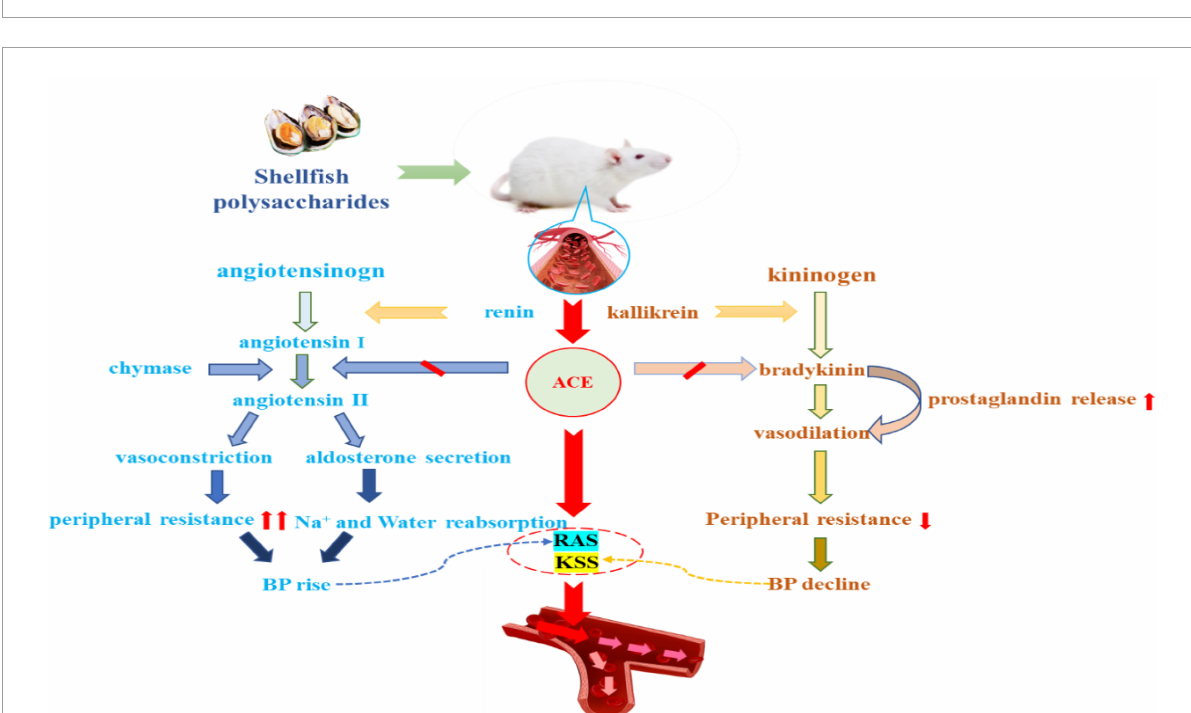
FIGURE3 Shellfish polysaccharides inhibit angiotensin-converting enzyme and regulate blood pressure.